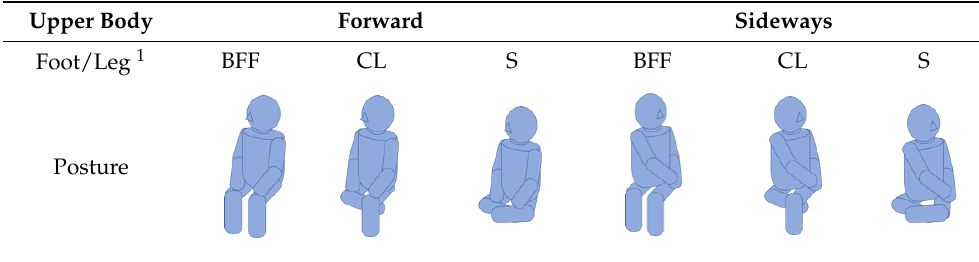
Table 1. Specification of the driving simulator and turntable.